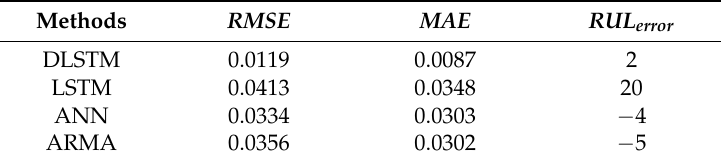
Figure 6. Comparison of four different methods for satellite Li-ion battery RUL prognosis: ( a ) DLSTM for RUL prognosis; ( b ) LSTM for RUL prognostic; ( c ) ANN for RUL prognosis; ( d ) ARMA for RUL prognosis. Table 2. Prediction performance comparison of four methods.